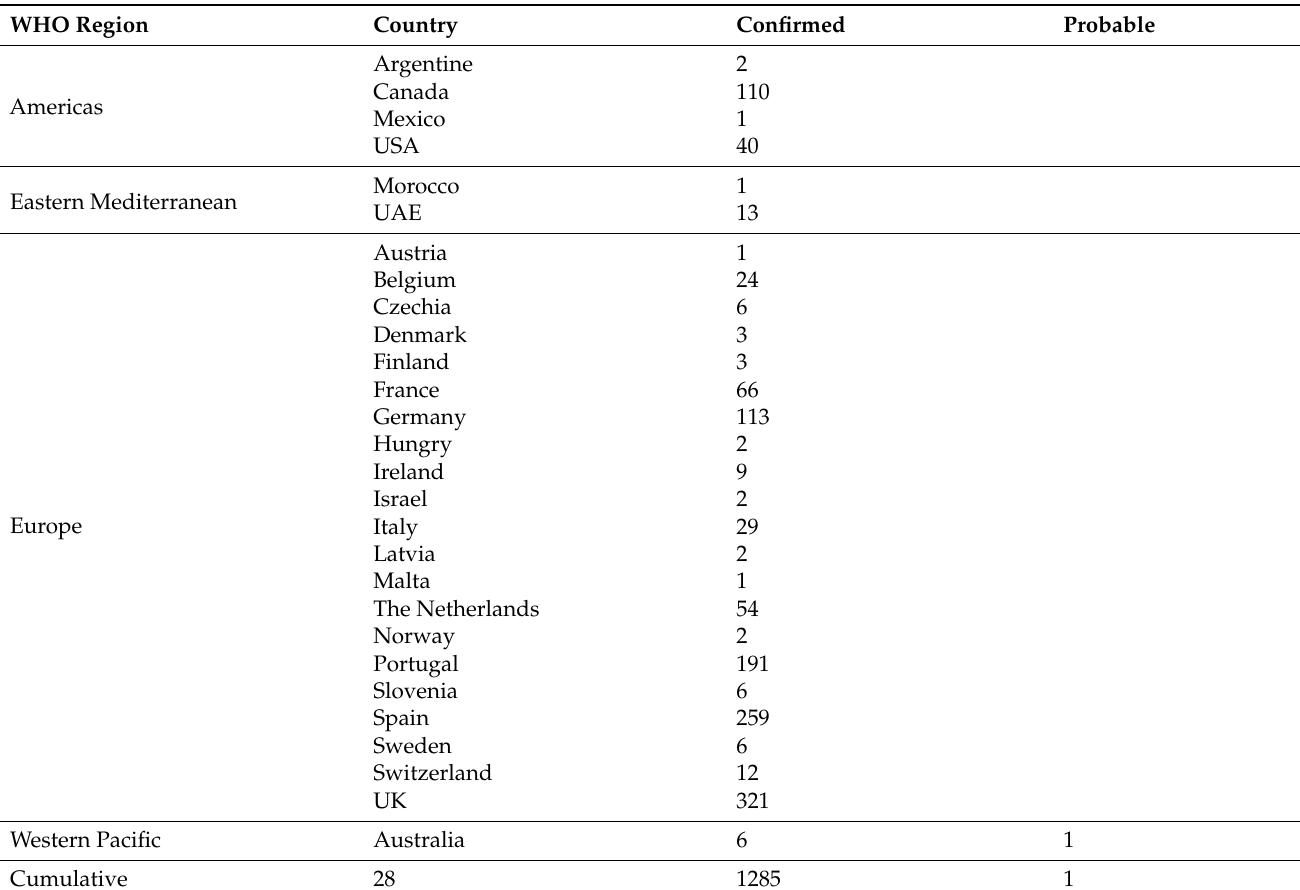
Table 3. Monkeypox cases formally announced by WHO by area, from January 2022 through 15 June 2022